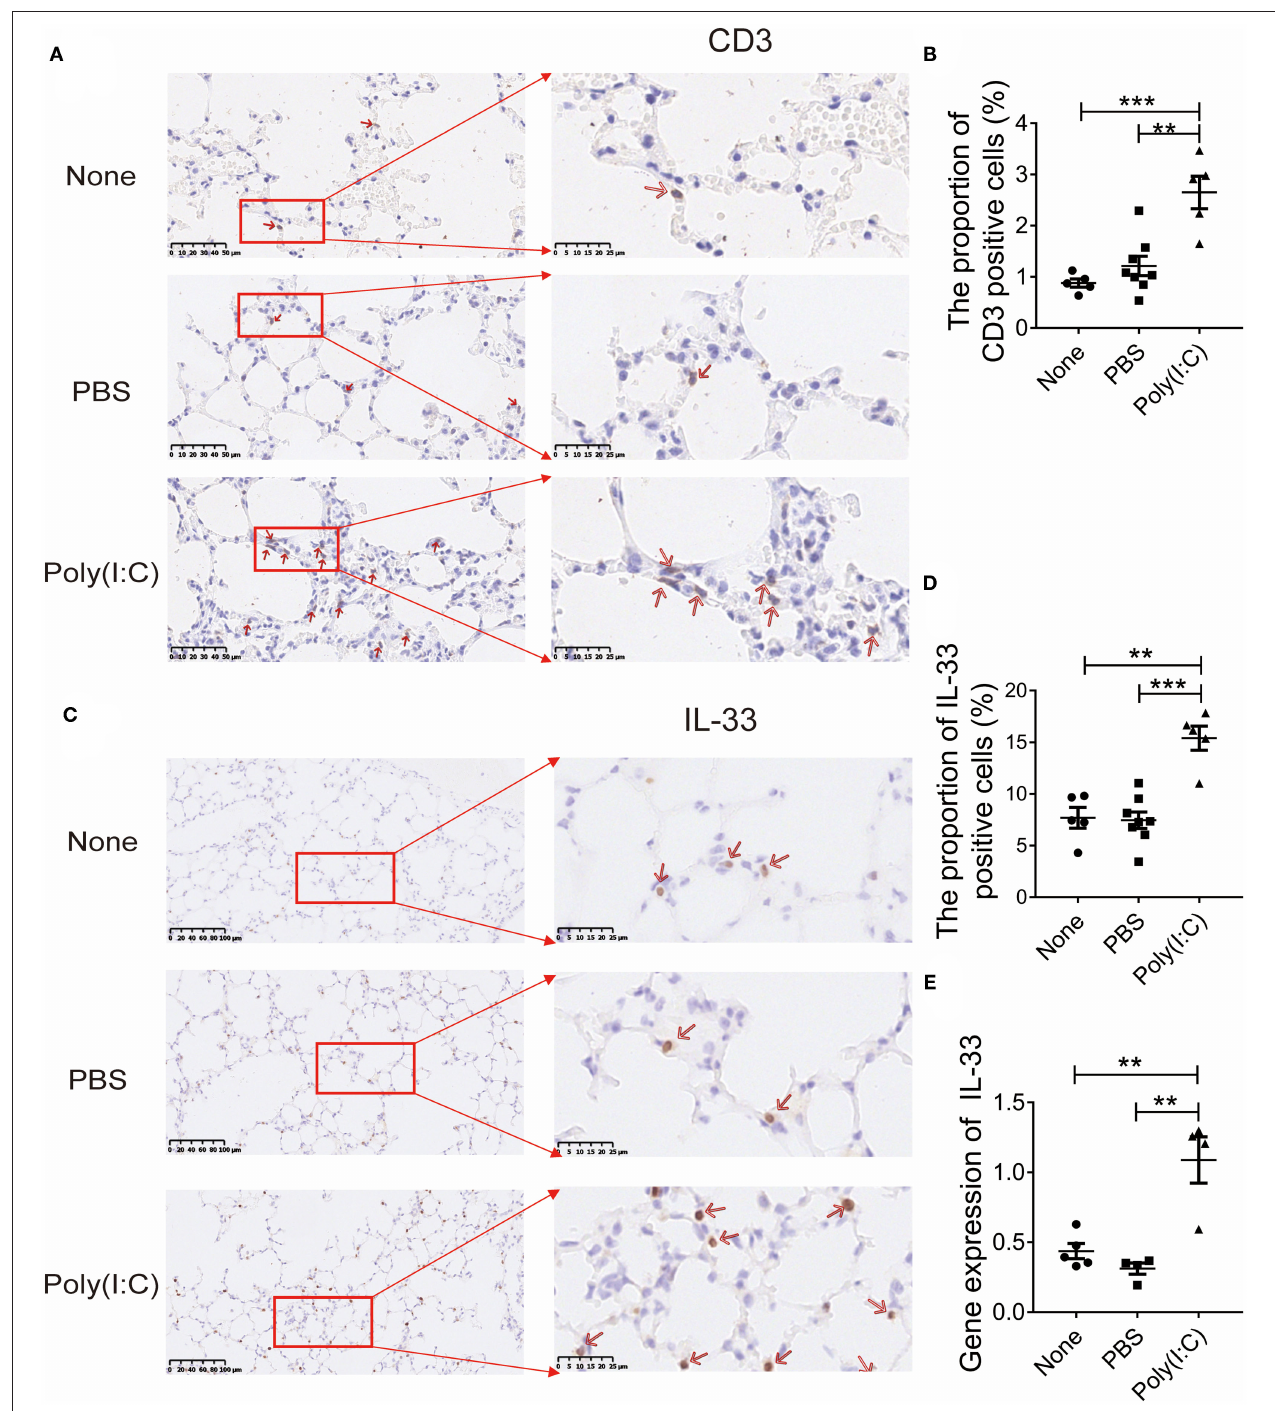
FIGURE 5 | Poly(I:C) treatment increased IL-33 expression and T cells proportion in the lung. (A) Immunohistochemical staining for CD3 expression in lung ( × 400, × 800) ( n = 5–8 per group). (B) The proportion of CD3 positive cells to total cells in lung per HPF. (C) Immunohistochemical staining for IL-33 expression in lung ( × 200, × 800) ( n = 5–8 per group). (D) The proportion of IL-33 positive cells to total cells per HPF. (E) The mRNA levels of IL-33 in lung ( n = 5, 5, 4). Data were presented as mean ± SEM, ** p < 0.01 and *** p < 0.001. condition of viral infection, which might explain the accelerated progression of salivary gland dysfunction in NOD mice after poly(I:C)